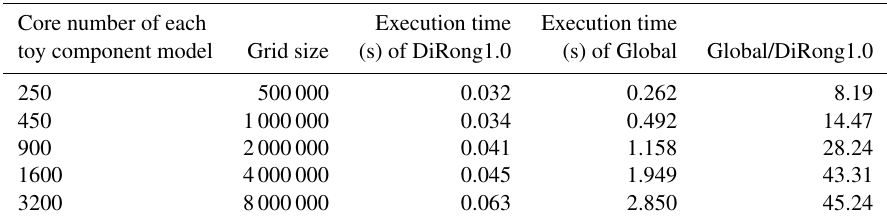
Table 11. Performance of DiRong1.0 and the comparison with the original global routing network generation (Global) when concurrently increasing the grid size and number of